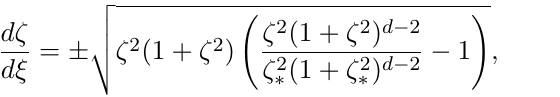
∼ O (1) , and positive DGP B